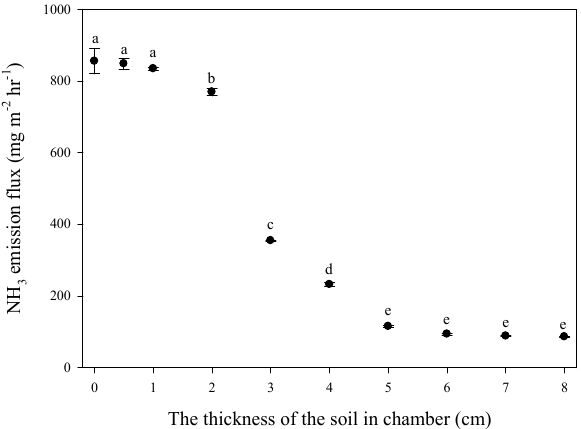
Figure 3. Changes in ammonia emission flux with different soil media thickness using dynamic chamber-capture system at 20 ℃ and pH 8 condition. Means with different letters are significantly different (Tukey’s test, p < 0.05). Error bar means standard deviation (SD, n = 3).